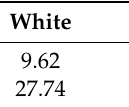
Table 9. Optimal coefficients for fitting the